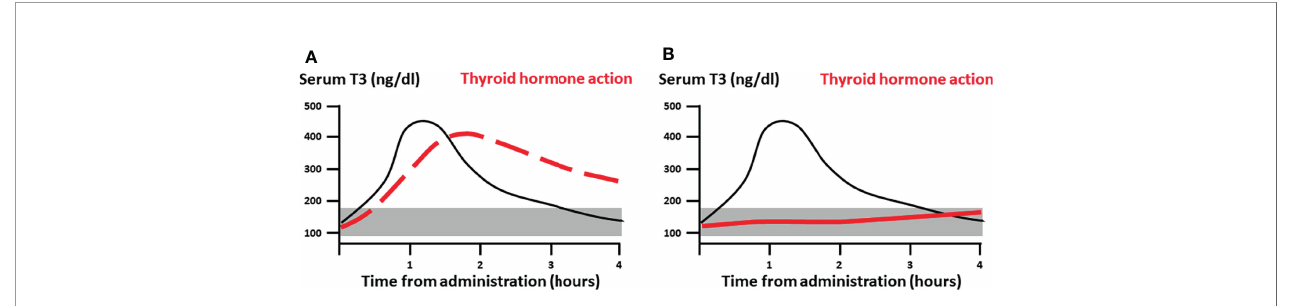
FIGURE 1 | Study hypothesis. (A) If clinically relevant, rapid action of LT3 (dashed red line), would be measurable following a pharmacological dose at or immediately after C max . (B) Conversely, if the thyroid action is entirely attributable to genomic signaling (continuous red line) one would expect minimal measurable effects during the distribution phase with a gradual and delayed onset. Black continuous line: pharmacokinetics of single dose LT3. The shaded area represents the reference range for serum